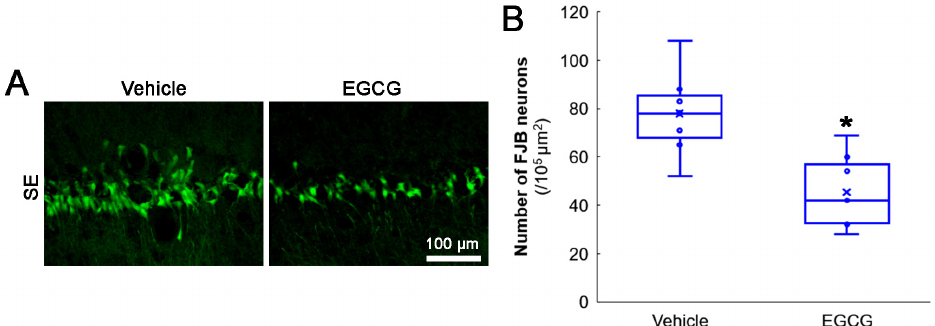
Figure 2. Effects of EGCG on SE-induced CA1 neuronal damage. EGCG diminished the number of FJB-positive-degenerating CA1 neurons in SE group. ( A ) Representative FJB-positive-degenerating CA1 neurons following SE. ( B ) Quanti fi cation of the number of FJB-positive neurons (* p < 0.05 vs. vehicle-treated animals; n = 7 rats, respectively).